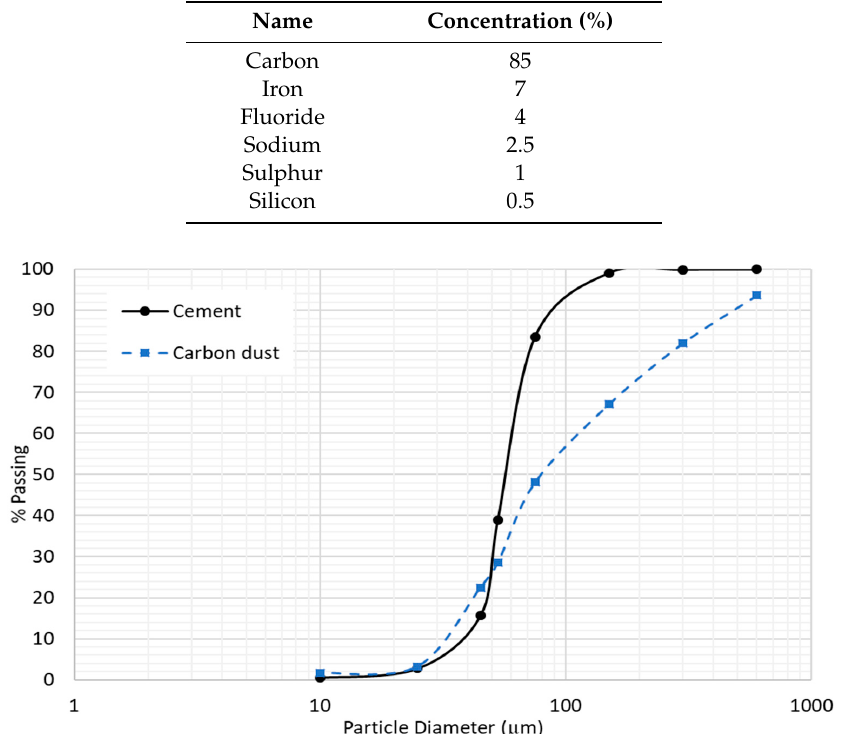
Figure 2. Particle size distribution of cement and carbon dust.